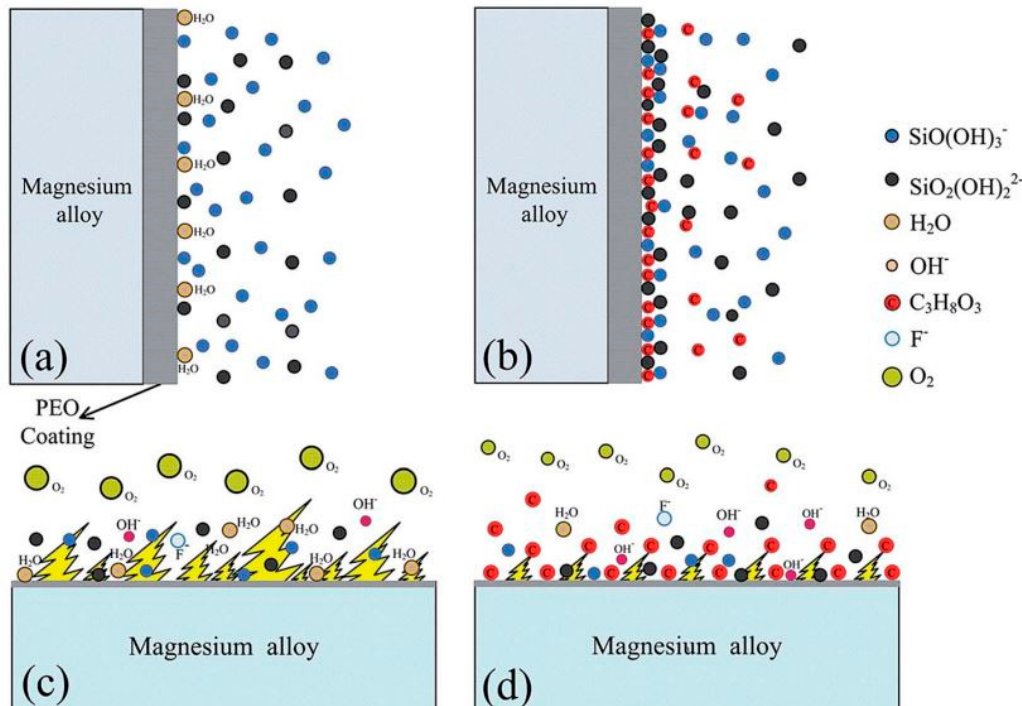
Figure 3. Schematic illustration of the SiO 32 − distribution at anode/electrolyte interface in two different electrolytes at the primary stages of the PEO treatment. ( a ) In a basic electrolyte, ( b ) in a basic electrolyte with GLY, ( c ) discharge mechanism of a basic electrolyte, ( d ) discharge mechanism of an electrolyte with GLY. Reprinted from permission from [60]. Copyright 2011 Royal Society of Chemistry.